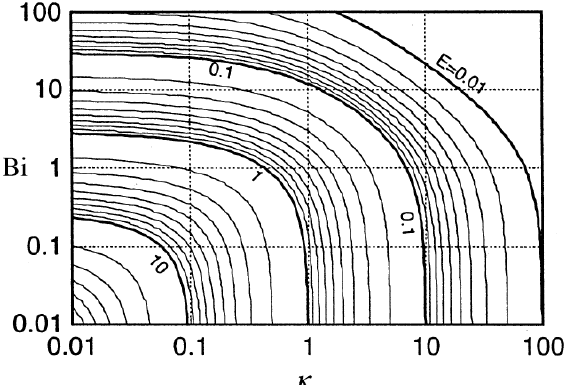
Figure 7. Nusselt number error map by using the LTE model, presented by Lee and Vafai [37].